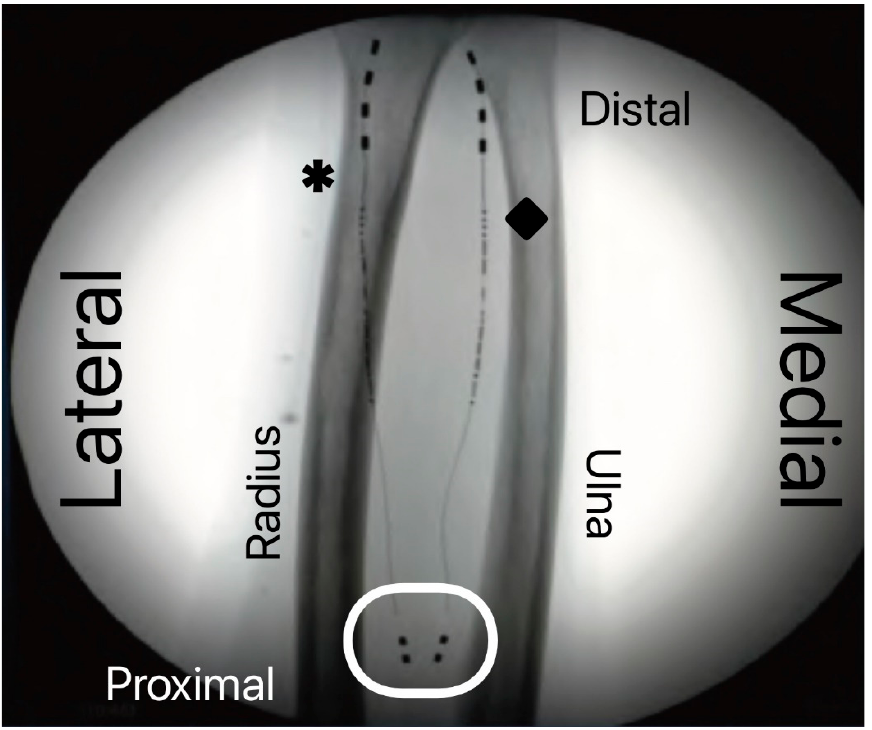
Figure 1. Fluoroscopy of the forearm illustrating the final position of the two peripheral nerve stimulation leads. The tips of the leads, with four stimulation contacts, lie next to the radial (asterisk) and median (diamond) nerve just proximal to the radial epiphysis. The white ellipse highlights the leads’ antennae which receive electrical energy from the external generator; energy is then converted into the actual stimulation current by the circuitry embedded in the body of the lead.